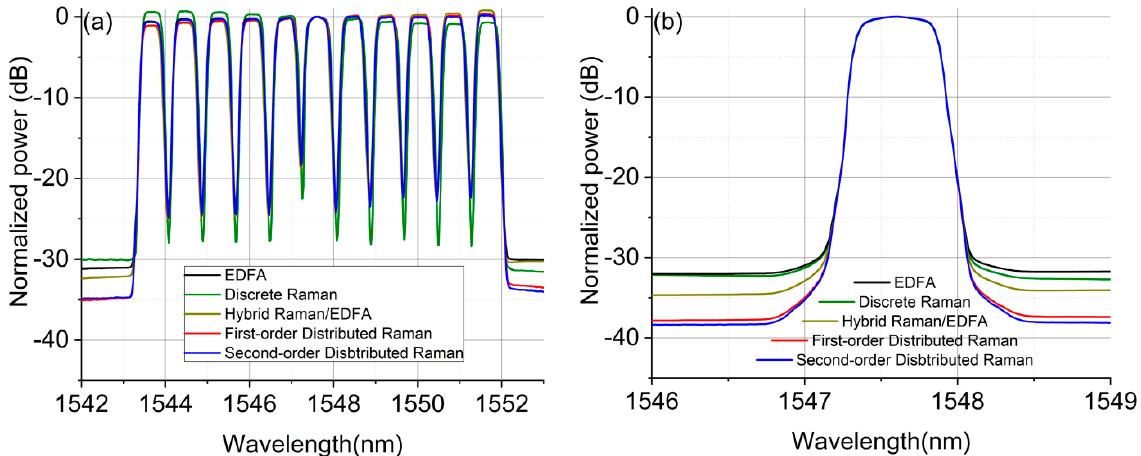
Figure 3. The output spectra from different optical amplifiers over a 75.6 km SMF: ( a ) with 11-channel input; ( b ) with 1 channel input.